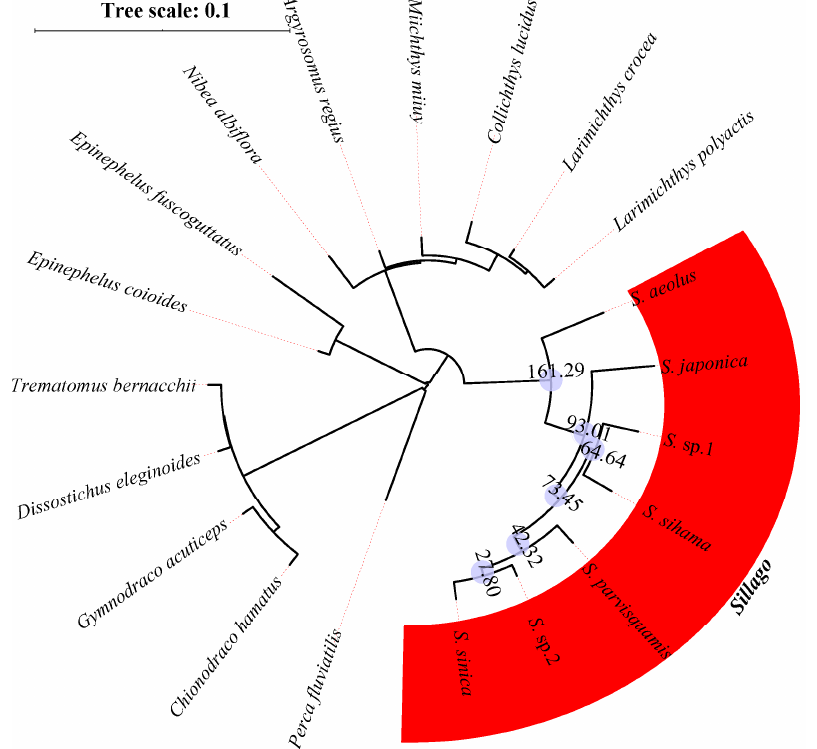
Figure 2. Inferred phylogenetic relationships and divergence times (data in the blue circles) of the seven Sillago species based on the concatenated nucleotide sequences.